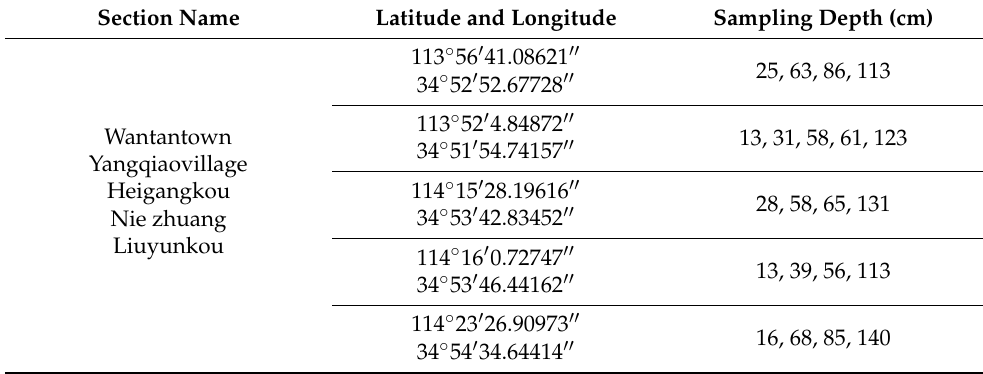
Table A1. Soil sampling point locations.